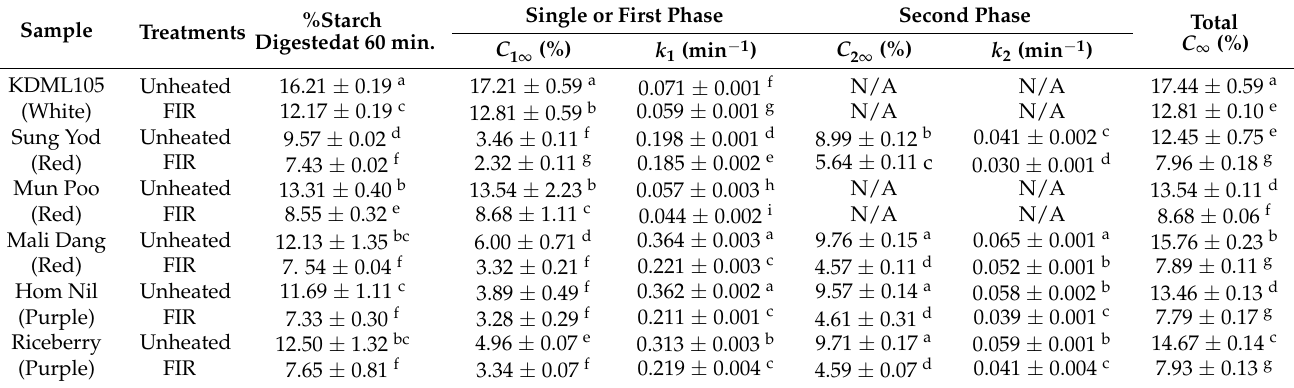
Table 4. The estimate values from LOS plots for all pigmented rice varieties as affected by